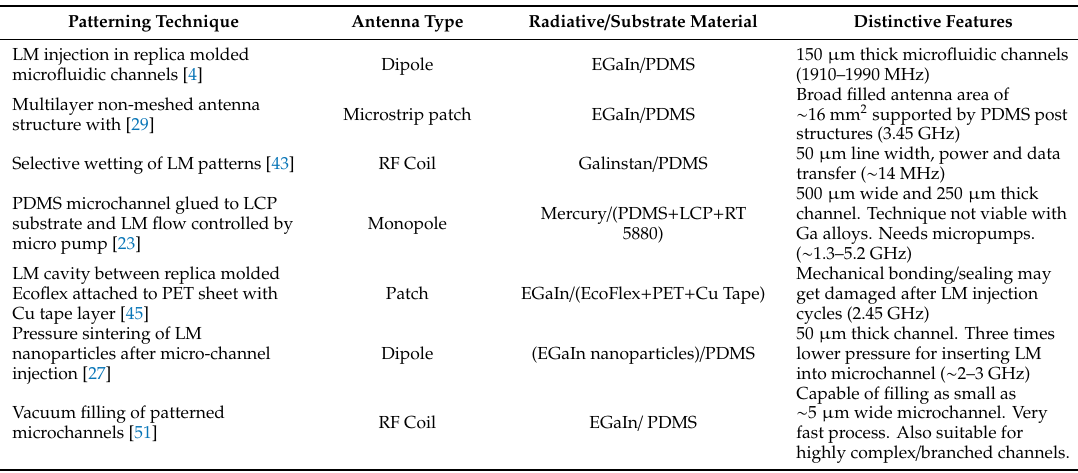
Table 2. LM Antenna patterning techniques based on soft/photolithography fabrication method. Abbreviations: LCP, liquid crystal polymer.